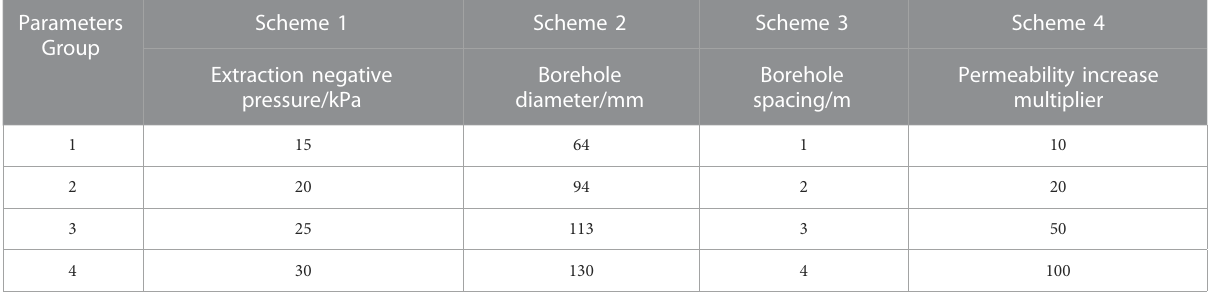
TABLE 3 Comparison scheme of different gas extraction